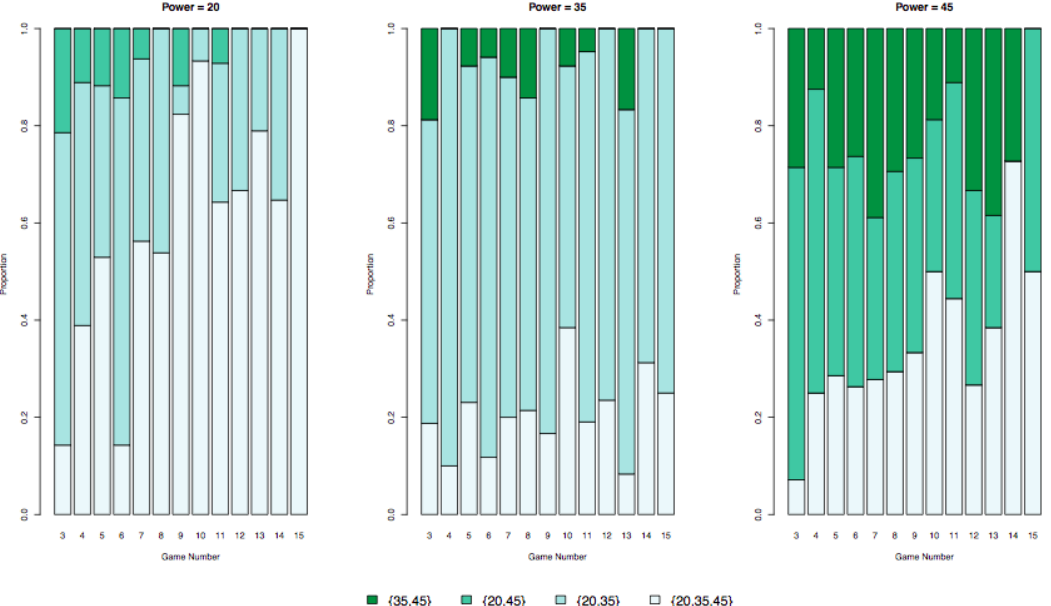
Figure 4. Percentage of proposed coalition at the start of every game, by game and agent’s power. Observation 4. Responses are dependent on an agent’s drawn power. Higher-powered agents tend to accept two-person coalitions offered by an agent with a lower power. A substantial proportion of responses accept the grand coalition when offered.